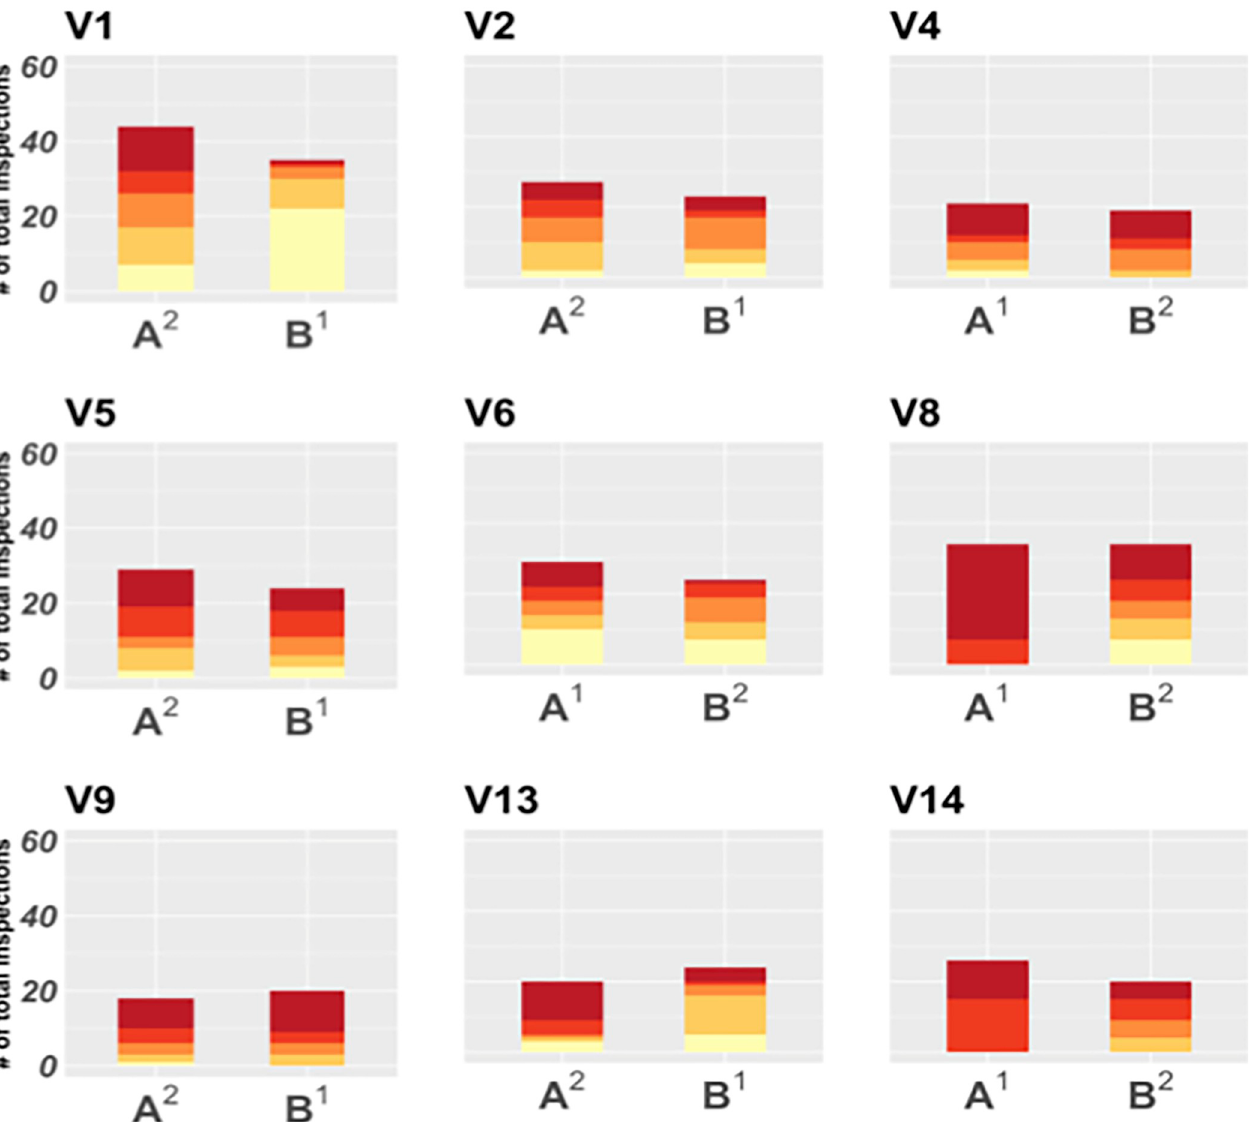
Fig 8. Distribution of household infestation risk quintile of households inspected by participants in the Miraflores Trial. Each set of two bars represents one participant, and each bar, a study arm (A and B). Colors are ordered by risk quintile, going from the lowest (light yellow, bottom) to the highest (dark red, top). Arm A was the poker incentive while arm B was pay per detection. The poker arm (A) had significantly different risk information use than arm B (POLR model, p < 0.001). Superscripts indicate arm